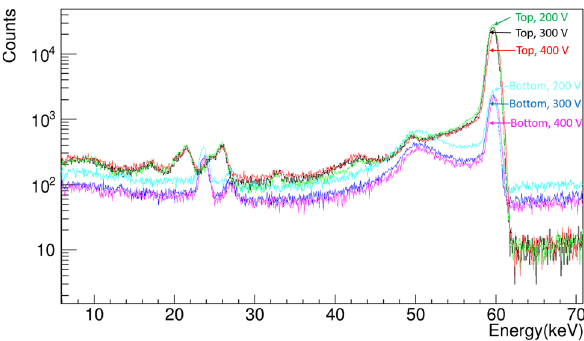
Fig. 15 EnergyspectraofaAm-241sourcemeasuredwiththedetector USD-W06. The spectra were taken at three voltages, 200 V, 300 V and 400 V with the source placed at the top and the bottom of the cryostat for each voltage